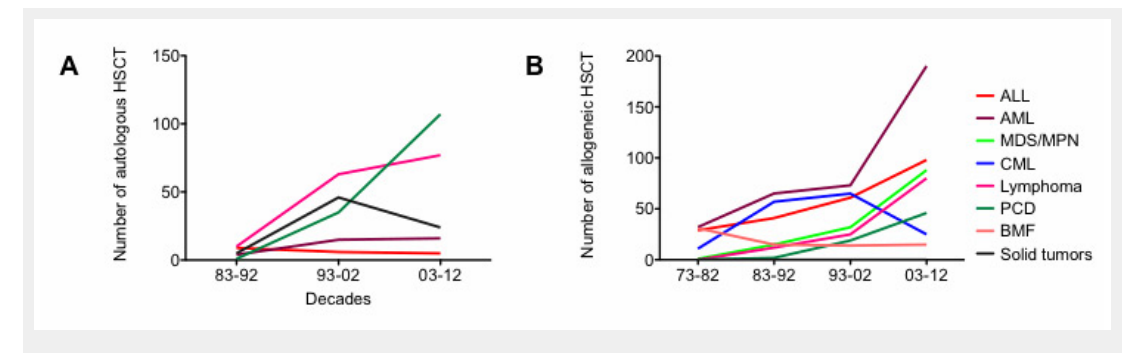
Figure 2 (A) Indications for autologous haematopoietic stem cell transplantation (HSCT) over the decades. (B) Indications for allogeneic HSCT over the decades. ALL = acute lymphoblastic leukaemia; AML = acute myeloid leukaemia; BMF = bone marrow failure; CML = chronic myeloid leukaemia; MDS/ MPN = myelodysplastic syndrome / myeloproliferative neoplasm; PCD = plasma cell